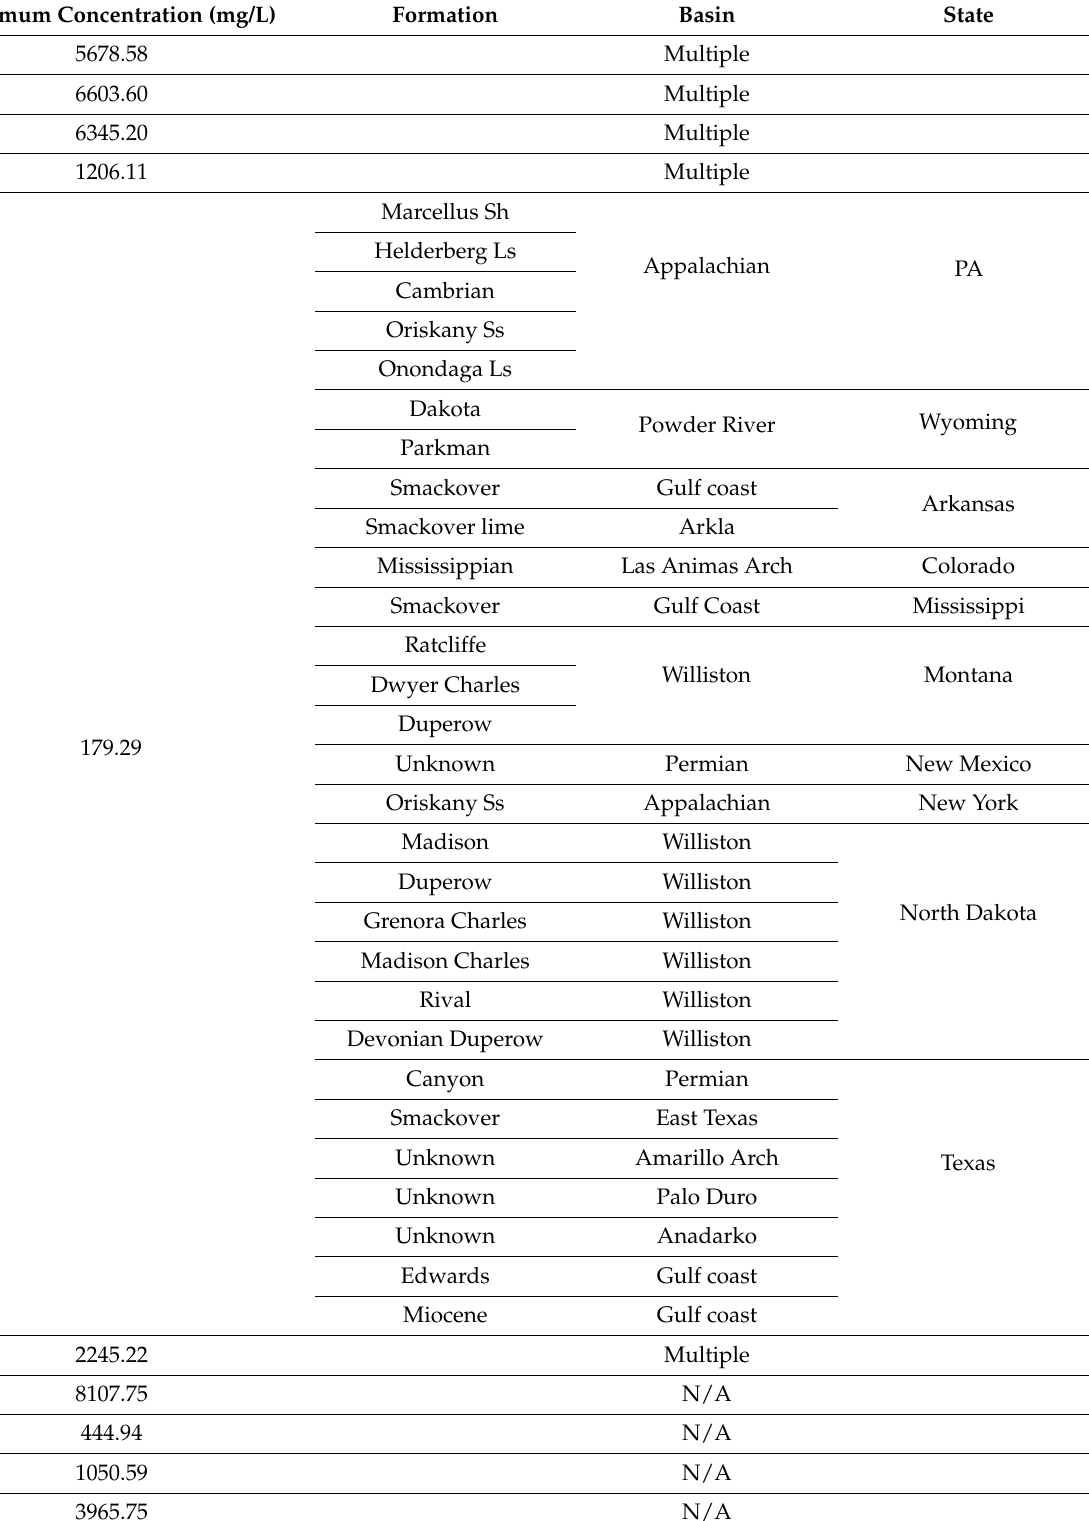
Table 4. Metal thresholds and abundance. Minimum concentration of metals required for feasible extractions and their abundance. Calculations are based on treatment costs of USD 2.32/bbl, further isolation processes not